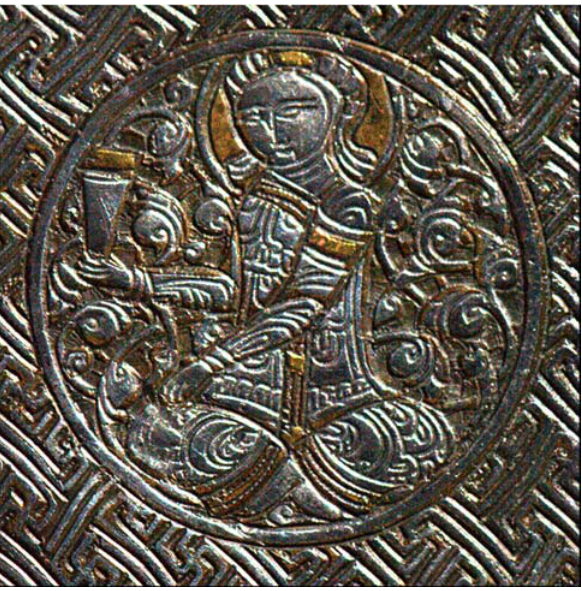
Figure 8. Roundel on front of handbag illuminated by lamp 48, at a ‘one o’clock’ position and an elevation of